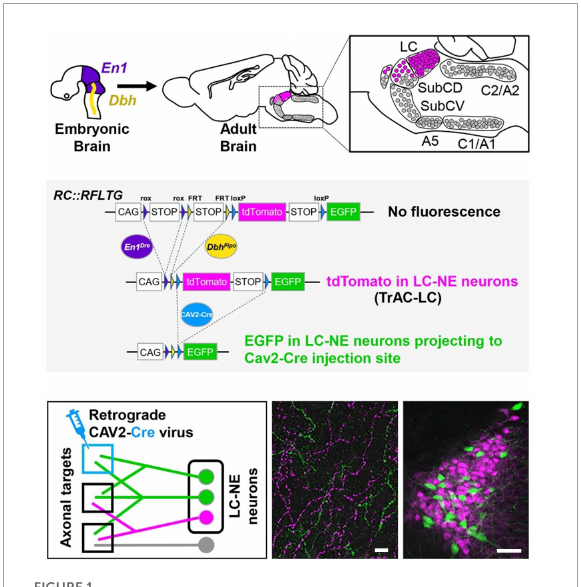
FIGURE1 TrAC (Tracing Axon Collaterals) permits fluorescent labeling of genetically defined neuron populations based on axonal projections. (Top) Neurons with a history of En1 and Dbh expression constitute the locus coeruleus and an adjacent portion of dorsal subcoeruleus. (Center) In mice heterozygous for En1 Dre , Dbh Flpo , and the RC:RFLTG indicator allele, locus coeruleus (LC)-norepinephrine (NE) neurons are labeled constitutively with tdTomato (red fluorescence) and switch to EGFP (green fluorescence) after Cre recombination. (Bottom) After injection of a retrograde CAV2-Cre virus (left schematic) , EGFP labels LC-NE neurons projecting to the injection site (right image) as well as all their axon collaterals in other brain regions (middle image) , scale bars = 100 µ m. Adapted from Plummer et al.